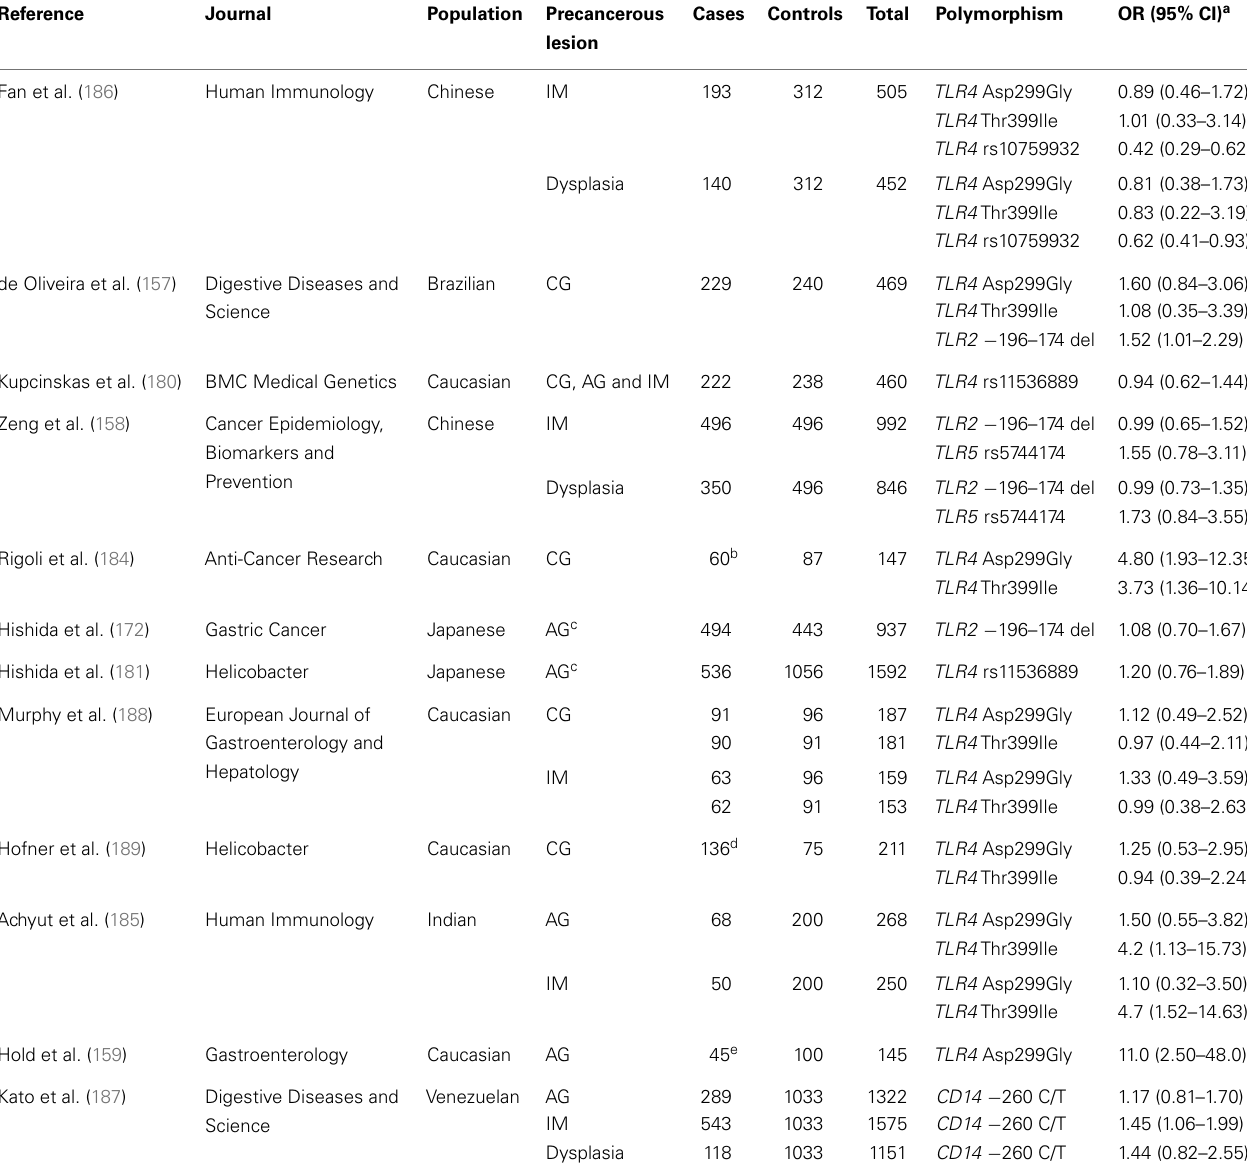
Table 2 | Genetic polymorphisms in theToll-like receptor signalling pathway that have been studied in relation to gastric precancerous lesions